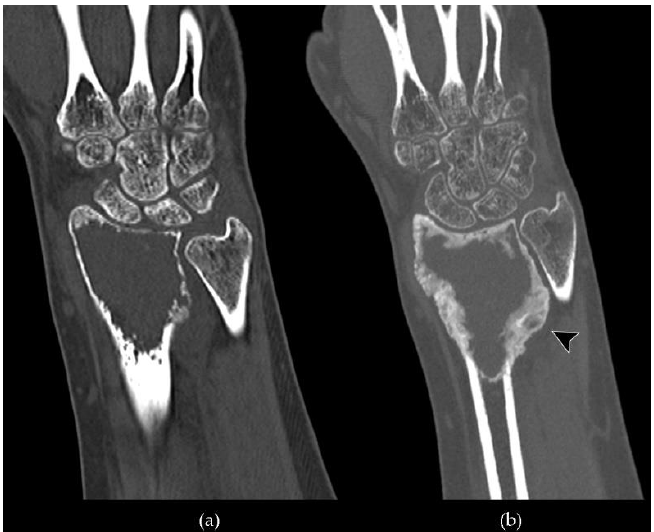
Figure 6. Coronal CT scan of a giant cell tumor of bone of the distal metaepiphysis of the radius treated with denosumab: ( a ) a pre-treatment image shows an osteolytic lesion with noticeable cortical thinning and endosteal scalloping; ( b ) a post-treatment image demonstrates peripherical osteosclerosis around the lesion with neocortex formation (arrowhead).